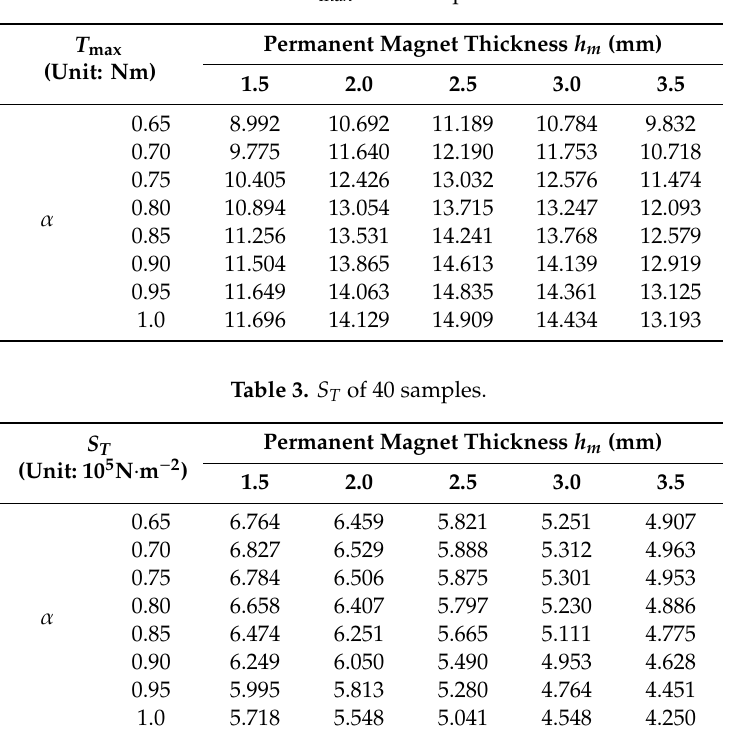
Table 2. T max of 40 samples.